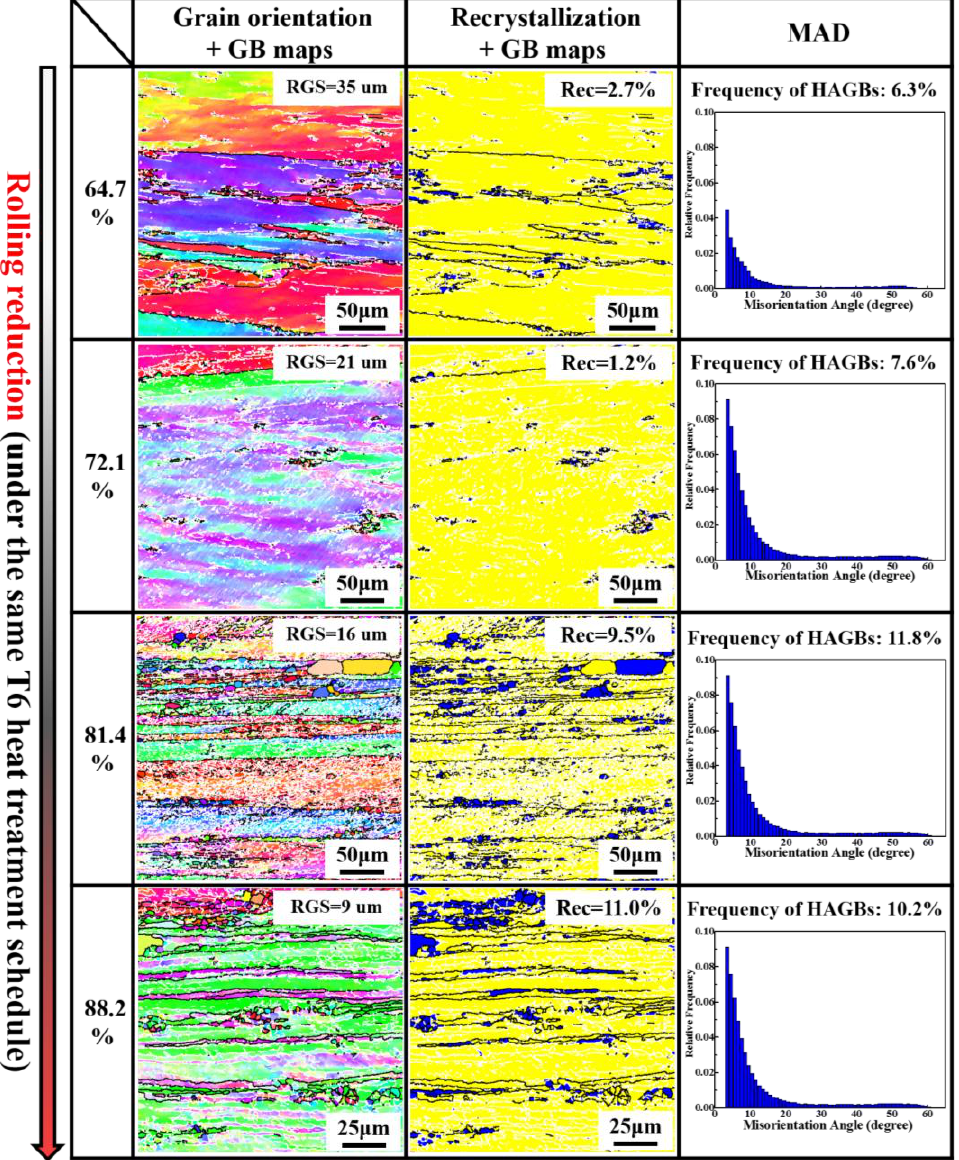
Figure 4. EBSD results of grain structure for the four T6 treated samples after different hot deformation.